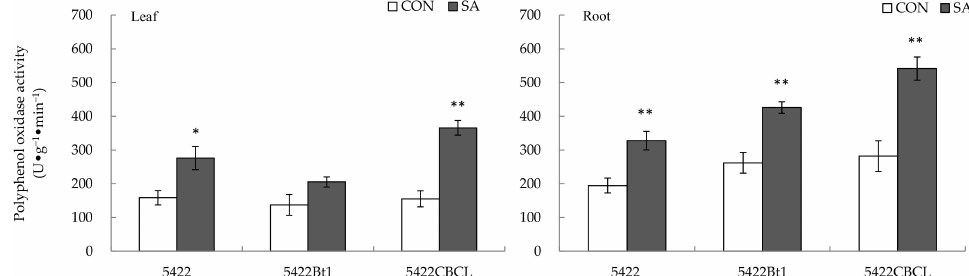
Figure 4. Direct and systemic effects of exogenous salicylic acid application to the aboveground part on the activity of polyphenol oxidase in the leaves and roots of conventional and Bt corns. The data in the figure are means ± standard errors. Significance among the data was determined by paired Student’s t -test. “*” showed p < 0.05, “**” showed p < 0.01. CON: control; SA: salicylic